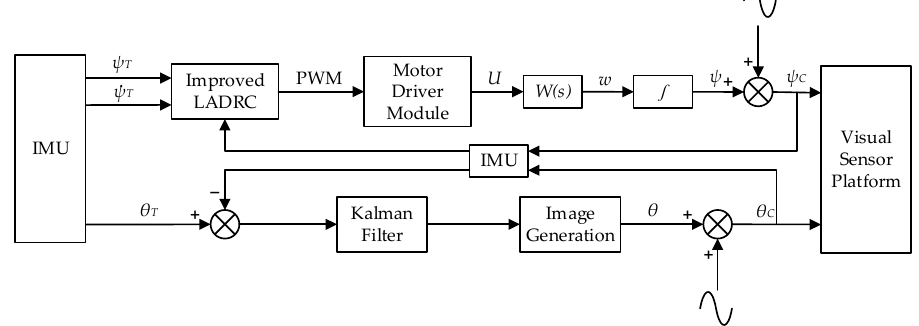
Figure 3. Stabilization block diagram of the improved linear active disturbance rejection control (LADRC) control, where θ and y are measured by inertial measurement units (IMUs), respectively. One of them is fixed on the camera and the other is fixed on the head of the shark-like robotic fish.